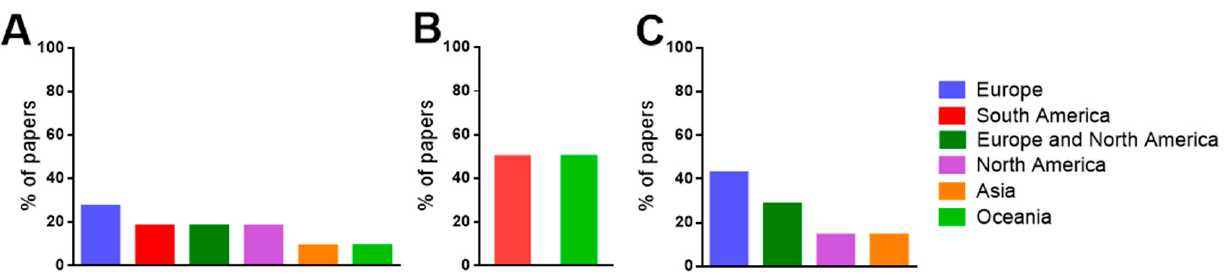
Figure 1. PRISMA flow diagram.